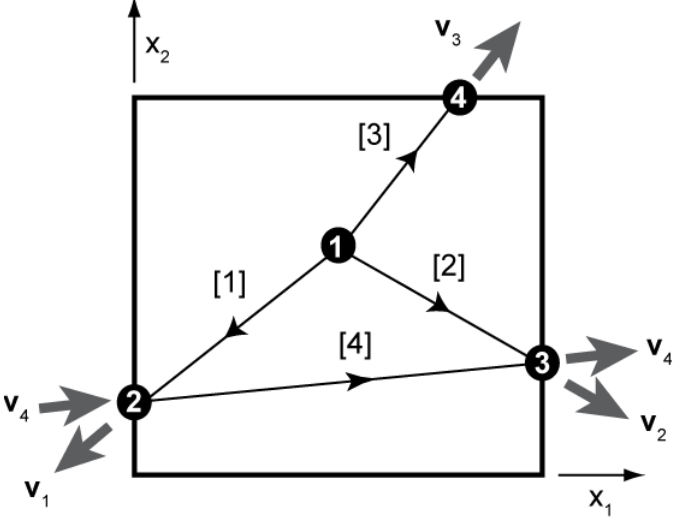
Figure 10. Schematic illustration of the VSF criterion on a simple fracture network. Note that the directions of the fluxes are also available (contrary to the NSF method of Figure 9). In this case, the vectors are summed over all the edges touching the border.